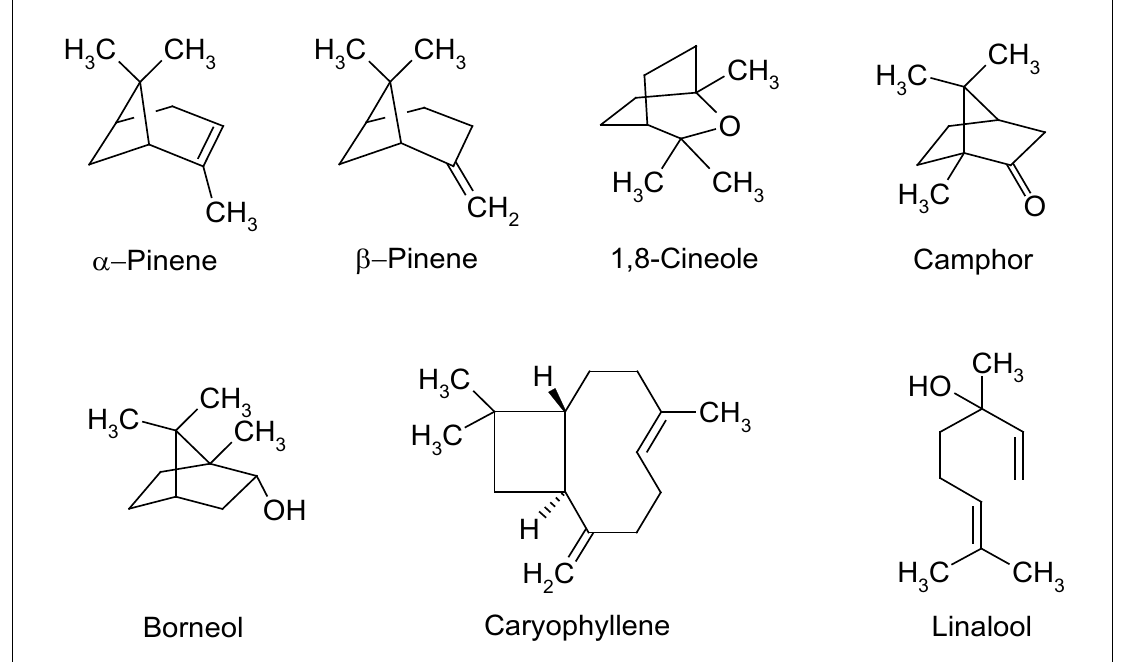
Figure 12. Main isoprenoids (mono- and sesquiterpenes) present in essential oil extracted from aerial parts of Salvia officinalis